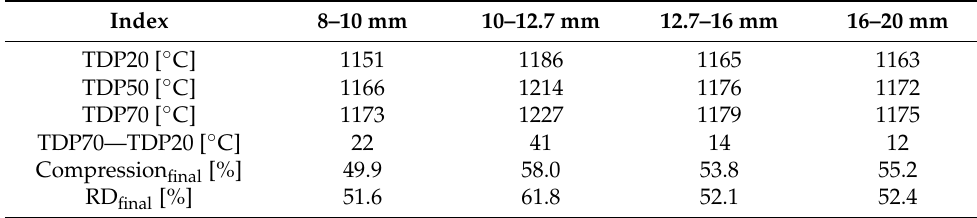
Table 3. Numerical values of the reduction-softening tests.